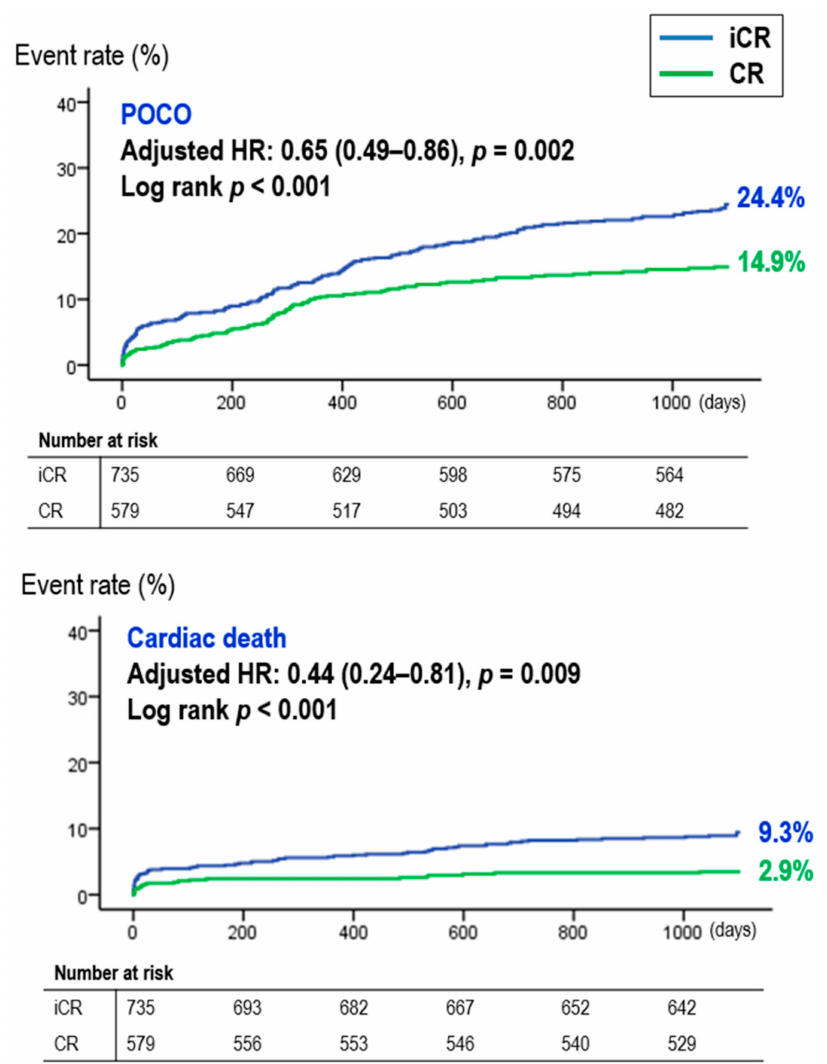
Figure 2. Survival curves during the three-year follow up period. Abbreviations: CR, complete revascularization; HR, hazard ratio; iCR, incomplete revascularization; POCO, patient oriented composite